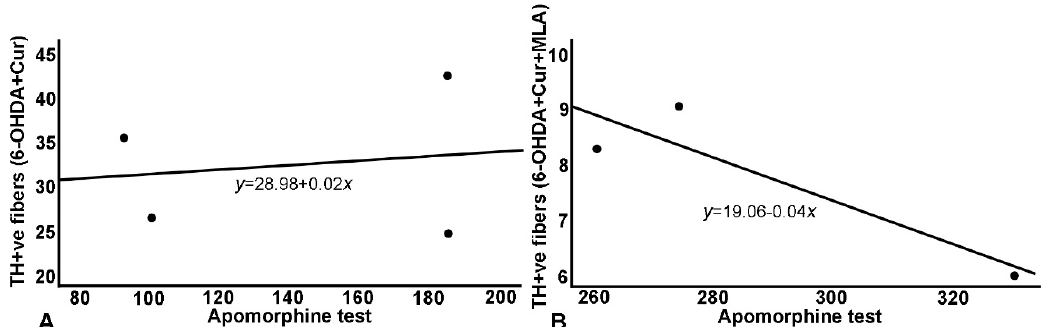
Figure 7. Relationship between apomorphine-induced rotation and striatal TH+ve fiber density: a similar relationship has been demonstrated with the same blunting effect on treatment as the effects seen with the SN cell count. ( A ) Correlation in 6-OHDA+Cur group, where curcumin administration improved striatal fiber density; ( B ) Concurrent MLA administration abrogated the effect of curcumin in 6-OHDA+Cur+MLA group.